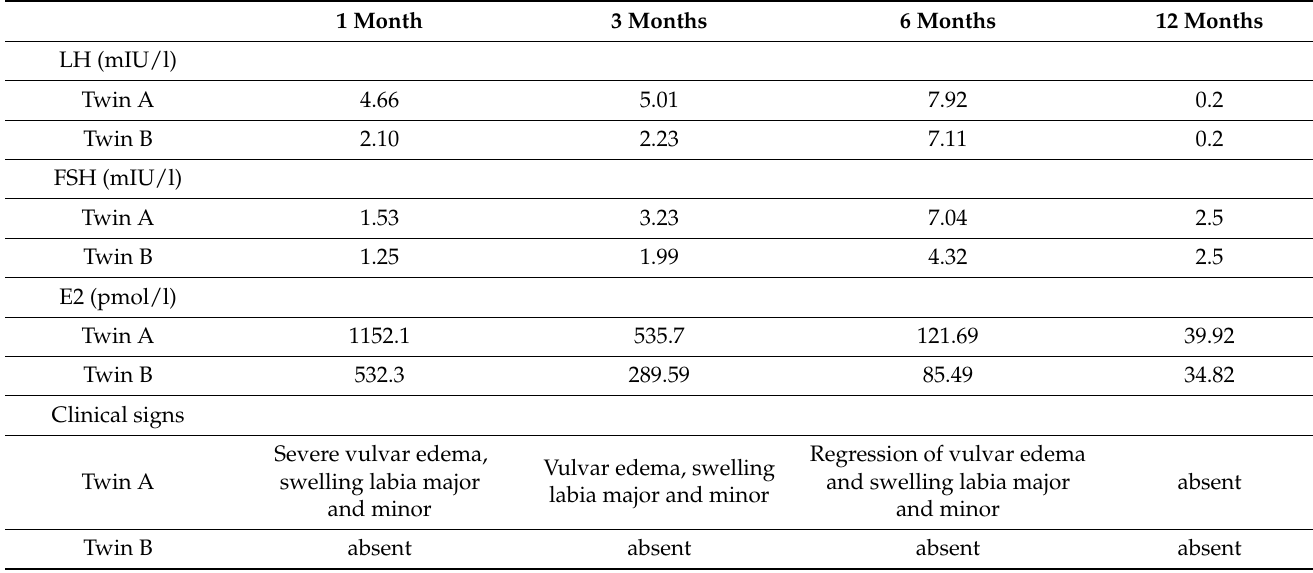
Table 2. Biochemical and clinical profile in a pair of preterm twin girls during 12-month follow-up. Comparison between the first and the second twin (twin A and twin B).